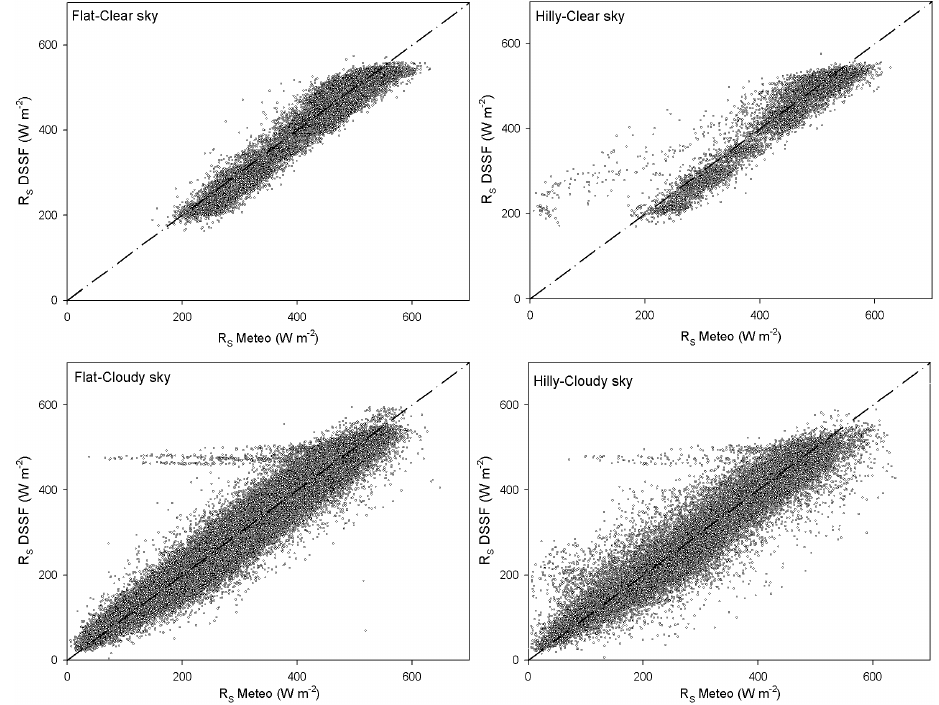
Fig. 2. Daily DSSF solar radiation ( R s DSSF) vs. daily solar radiation measured at meteorological stations ( R s Meteo) for 2008 to 2010, Figure 2. Daily DSSF solar radiation (R s DSSF) vs daily solar radiation measured at 3 segmented into subsets based on flat/hilly terrain and clear/cloudy sky condition. Solid line is the 1 : 1 meteorological stations (R s Meteo) for 2008 to 2010, segmented into subsets based on 4 flat/hilly terrain and clear/cloudy sky condition. Solid line is the 1:1 ratio. 5